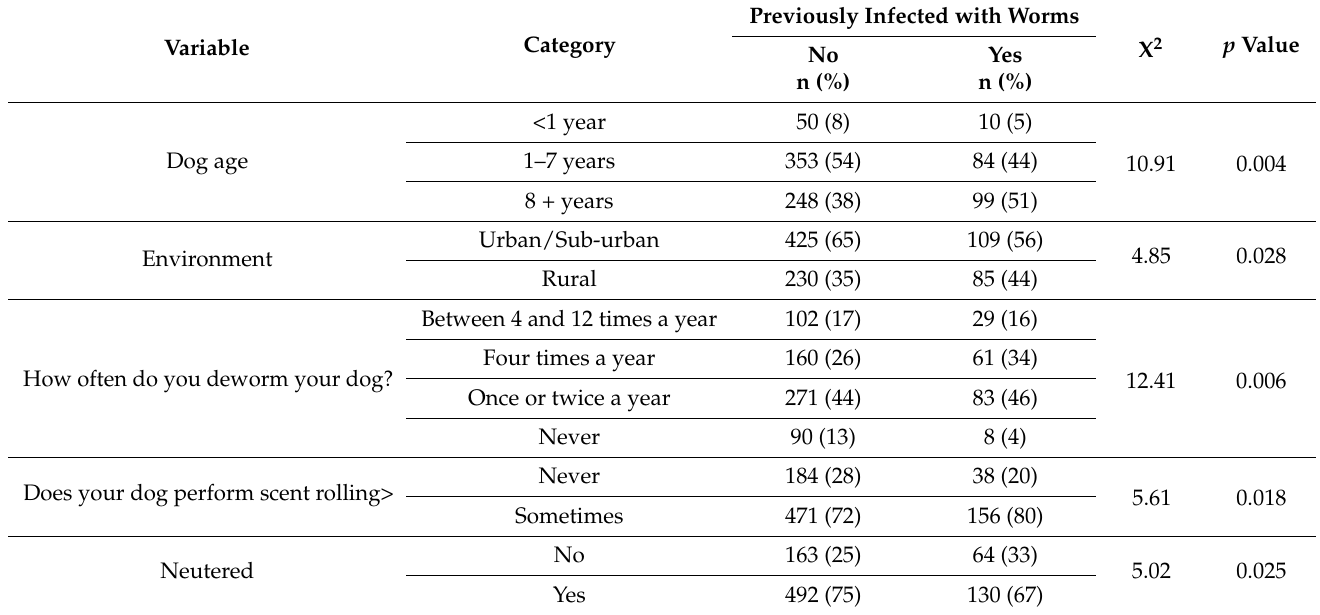
Table 5. Chi-squared (X 2 ) analysis for factors significantly associated ( p < 0.05) with dogs having a previous worm